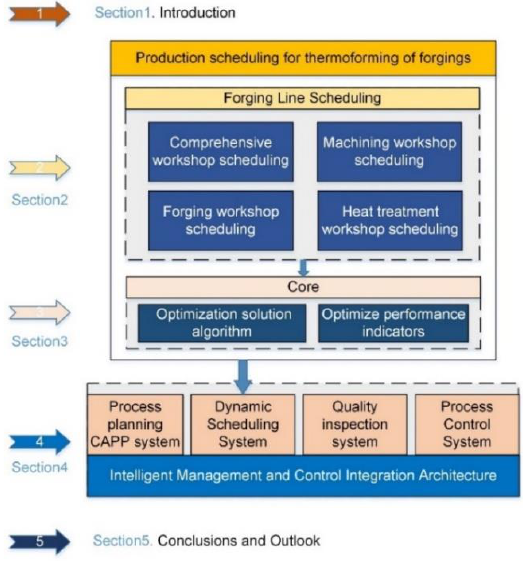
Figure 1. Organizational framework of the full text.